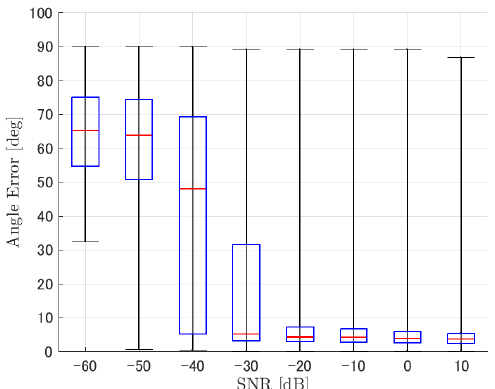
Figure 21. Direction estimation error shown in Figure 20 focusing on distance = 30